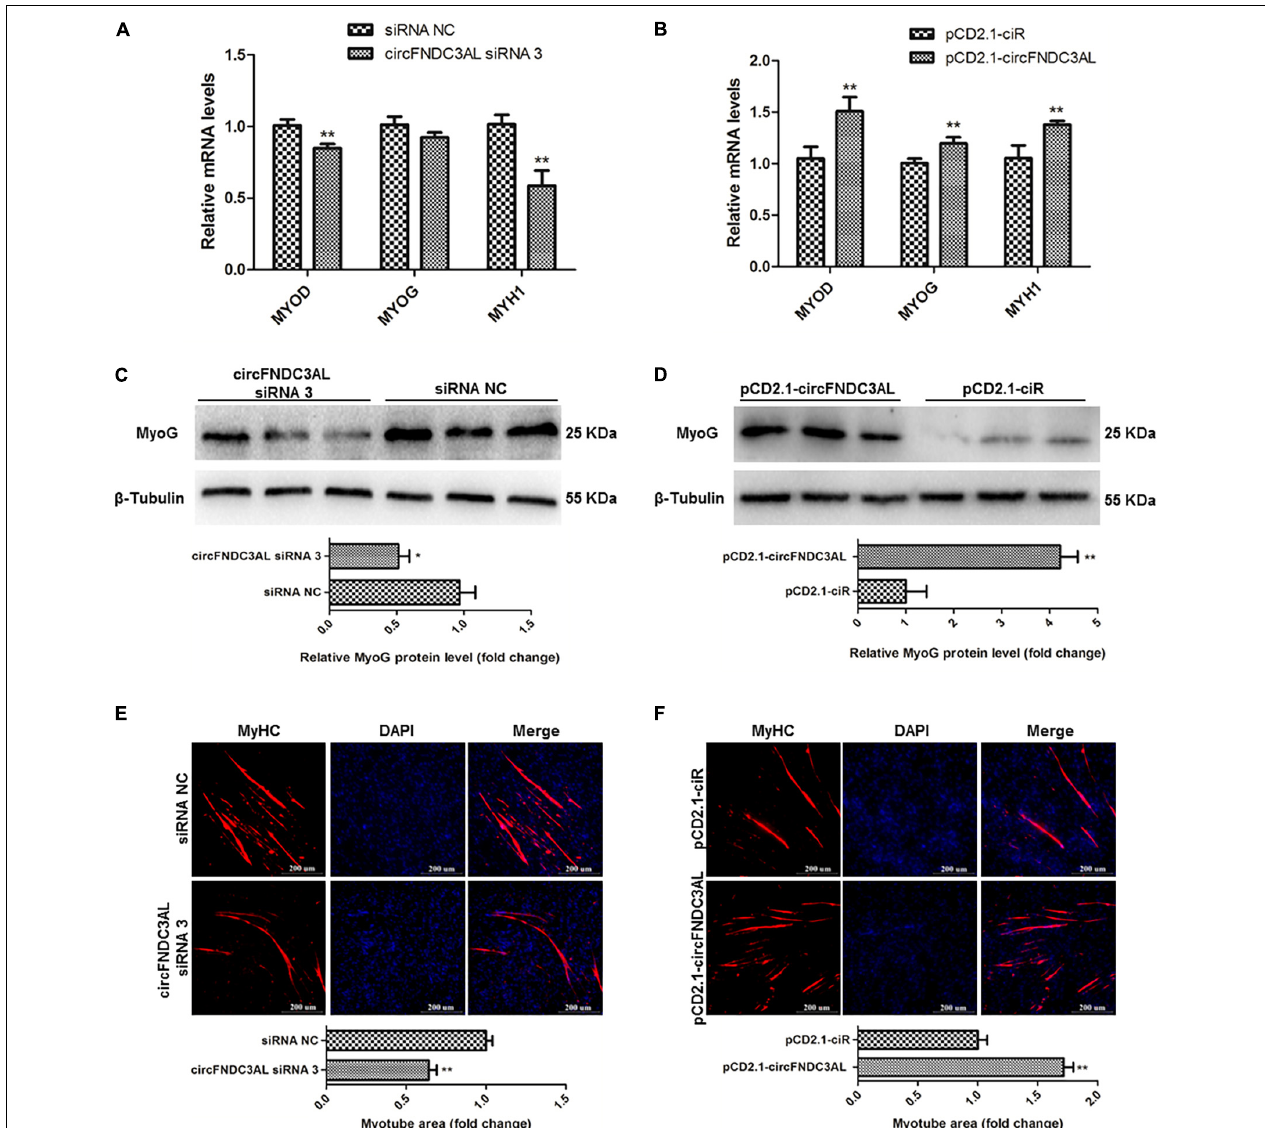
FIGURE 3 | CircFNDC3AL promotes the differentiation of SMSCs in chicken. (A,B) Differentiation-related genes mRNA levels were determined using qPCR after SMSCs were transfected with circFNDC3AL siRNA or overexpression plasmid. (C,D) MyoG protein levels were detected by western blot after circFNDC3AL were interfered or overexpressed in SMSCs. (E,F) Myotube areas were calculated at 72 h after circFNDC3AL was interfered or overexpressed in SMSCs. The scale bar represents 200 µ m. Values represent as means ± S.E.M. of three biological replicates. * P < 0.05; ** P <